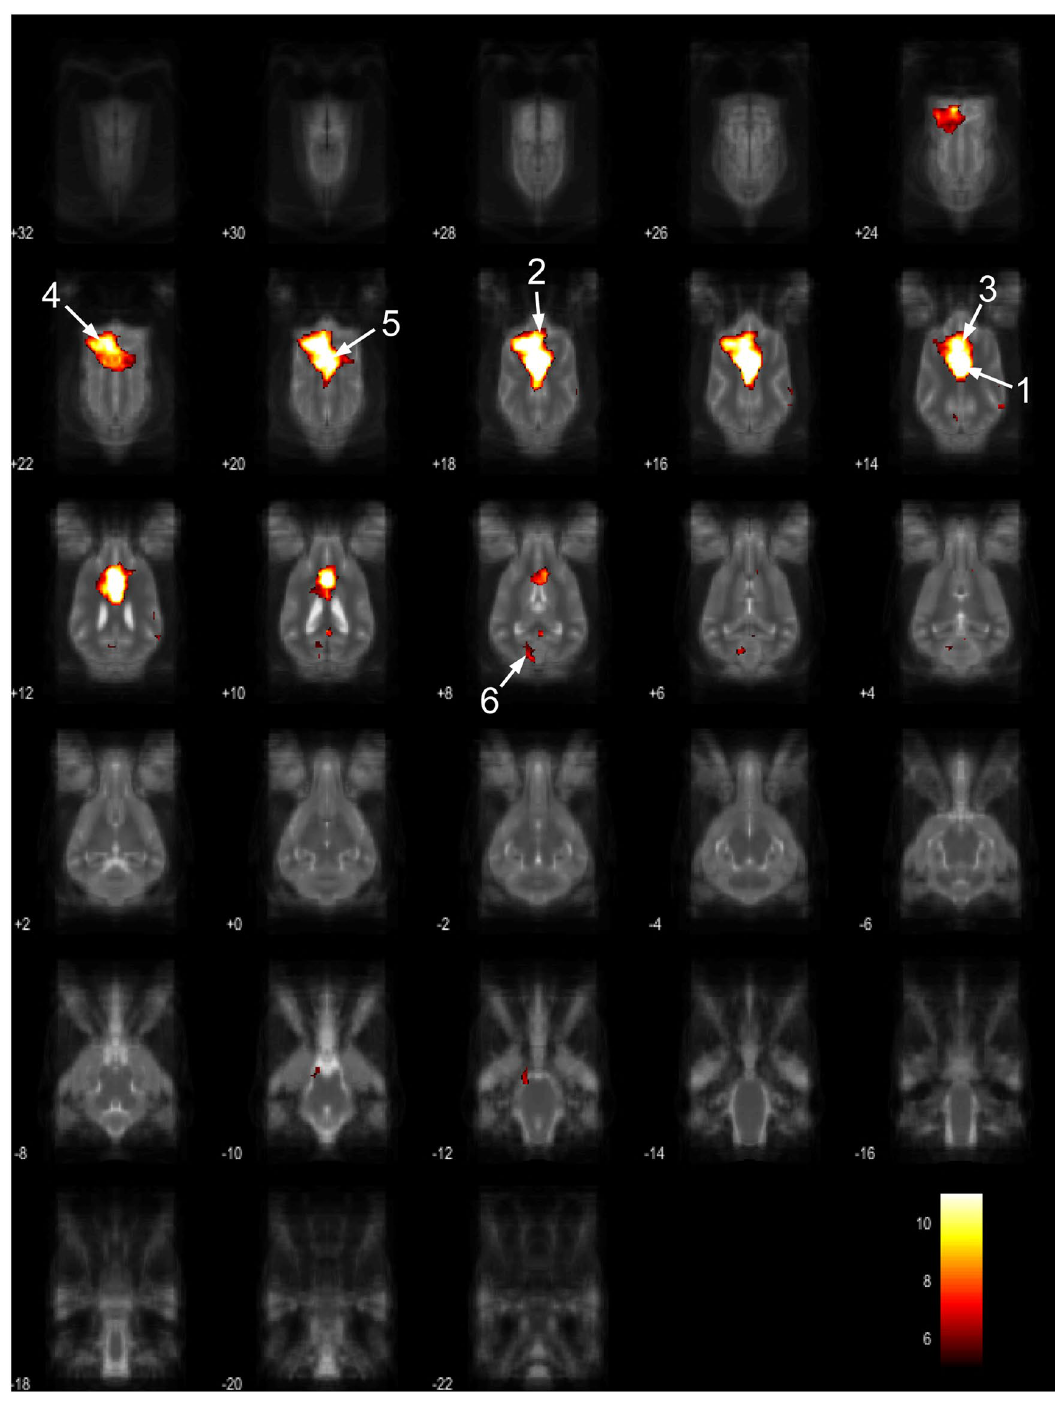
Figure 14. Resting-state network component K from the 15 component gICA. We report the results with a voxel-wise FDR corrected p < 0.001 and cluster treshold of FDR corrected p < 0.005. gICA components are presented as thresholded T-maps, corrected for multiple comparisons, overlaid on the Nitzsche atlas 15 . 1. mid- cingulate gyrus, 2. frontal gyrus, 3. gyrus genualis, 4. precruciate gyri, 5. postcruciate gyri, 6. splenial